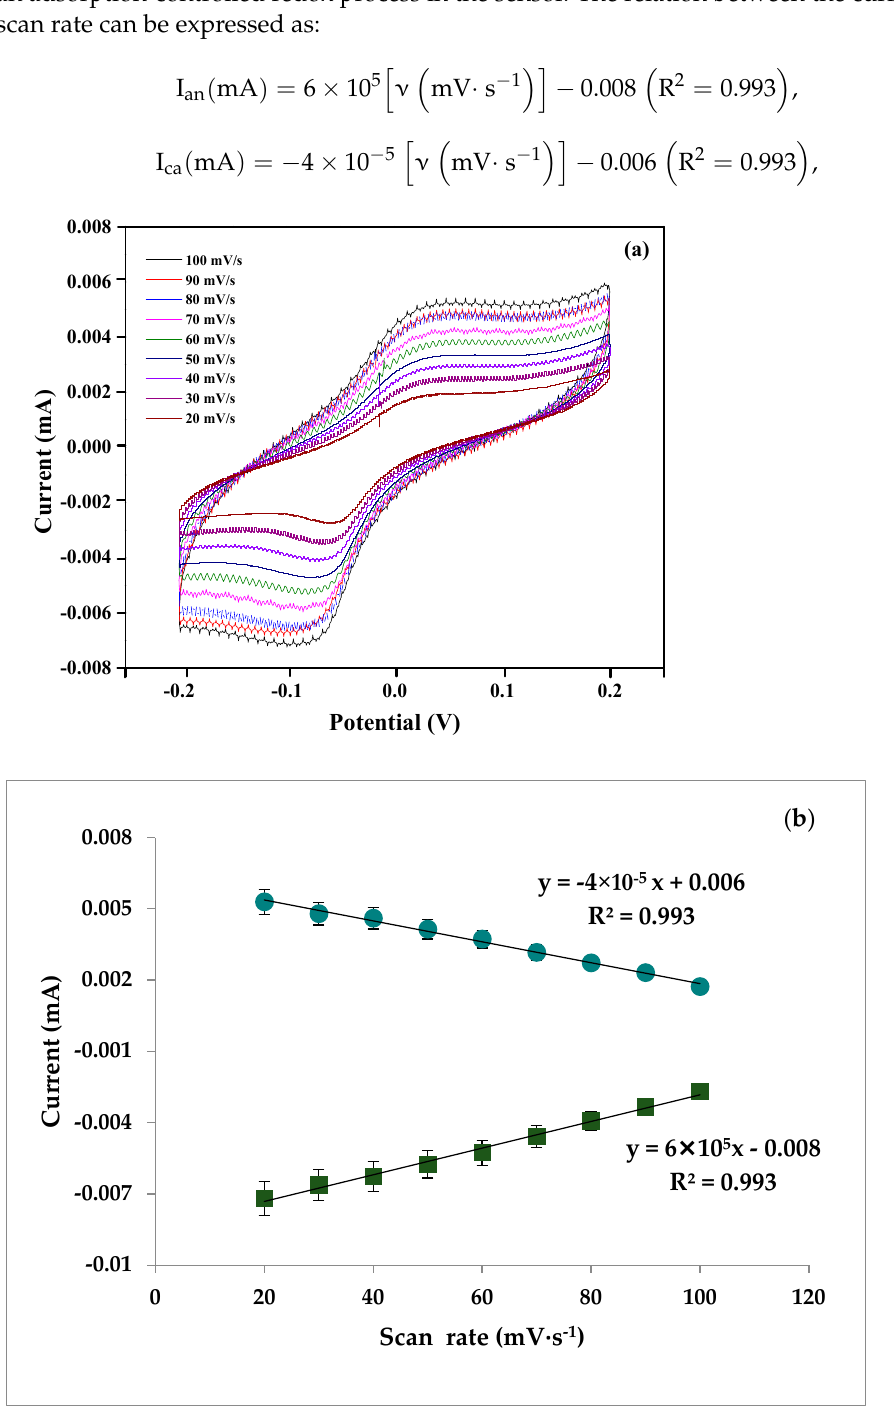
Figure 11. Determination of redox mechanism of aptasensor in 5.0 mM [Fe(CN) 6 ] 3 − /4 − and 0.1 M KCl electrolyte in the presence of 0.33 nM. ( a ) Change in CV curves at scan rates of 20, 30, 40, 50, 60, 70, 80, 90, and 100 mV/s. ( b ) Calibration curves of redox peak current vs. scan rate.